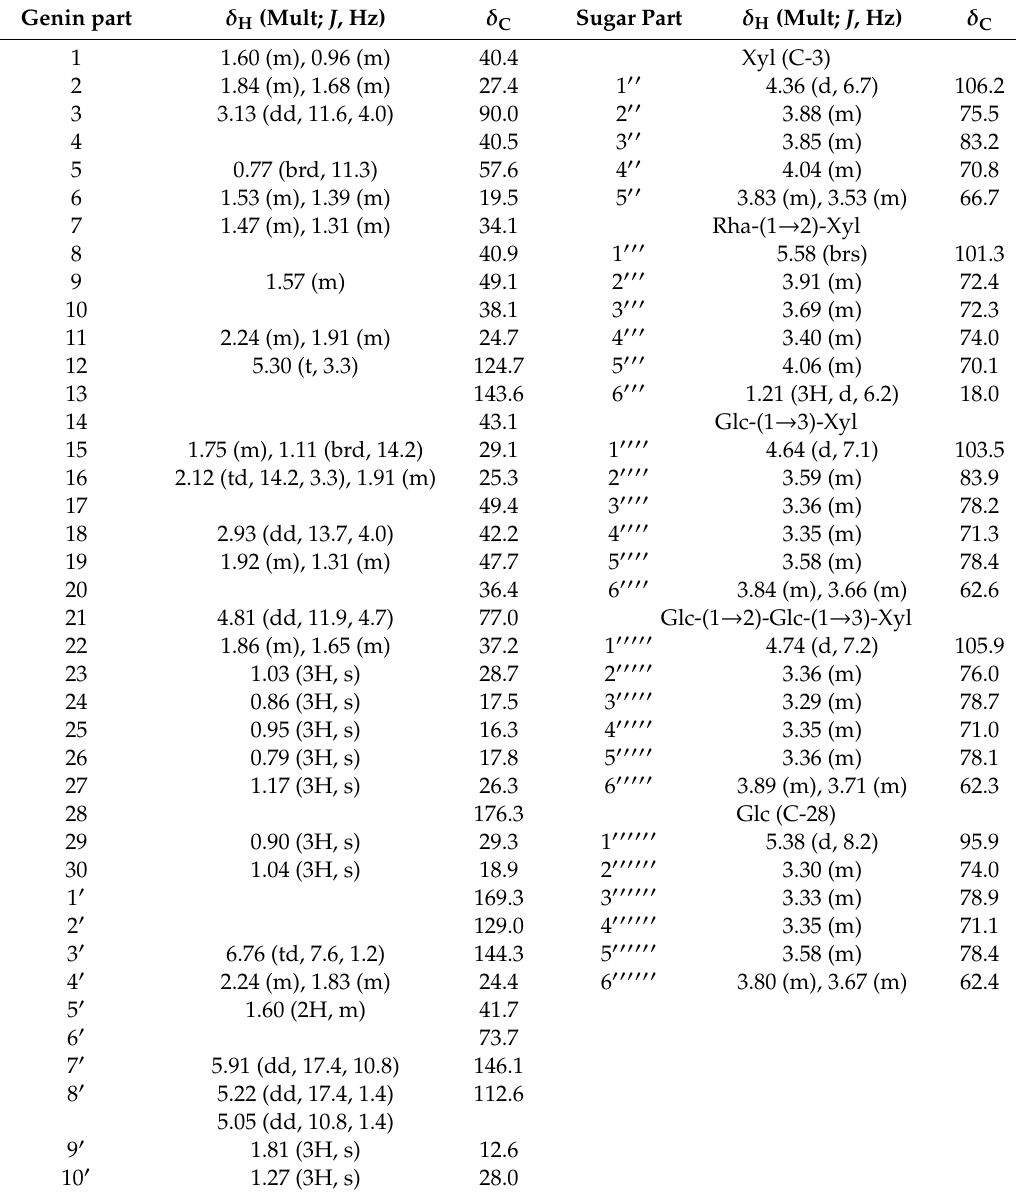
Table 1. 1 H- and 13 C-NMR spectroscopic data of 1 a (in CD 3 OD).